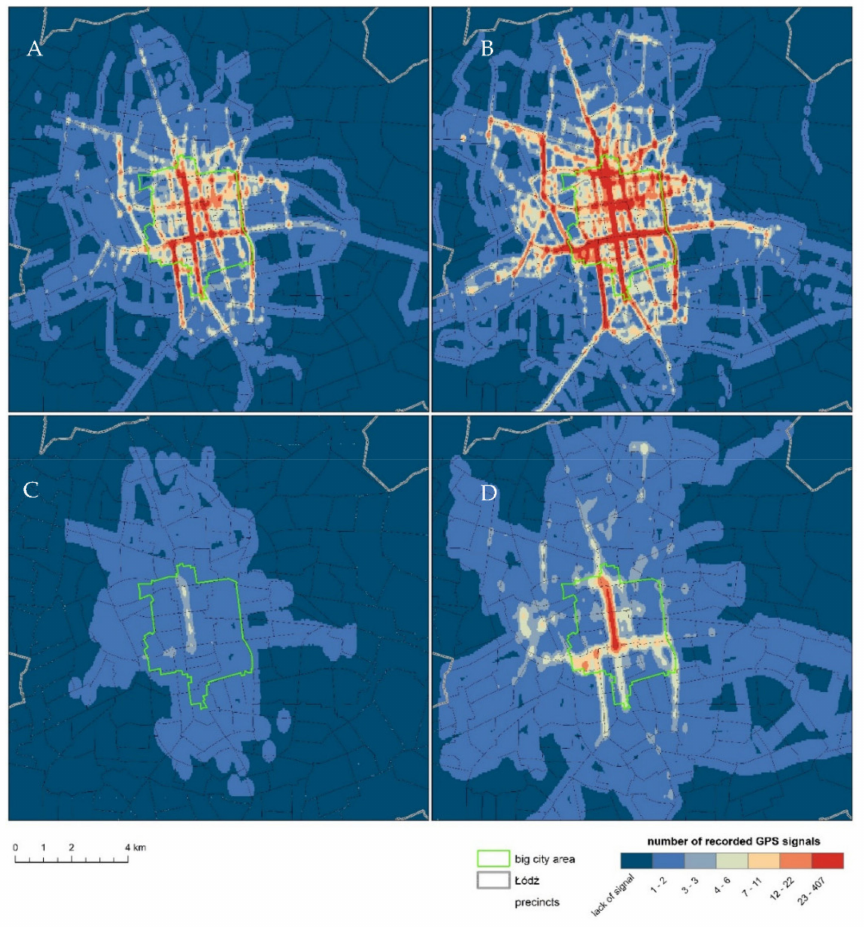
Figure 11. Spatial differentiation of ŁPB traffic density on workdays ( A , B ) and on weekends ( C , D ) between 8.00 a.m. and 9.59 a.m. ( A , C ) and from 4.00 p.m. to 5.59 p.m. ( B , D ) in Ł ó d´z in 2018. Source: own elaboration based on data from the Ł ó d´z City